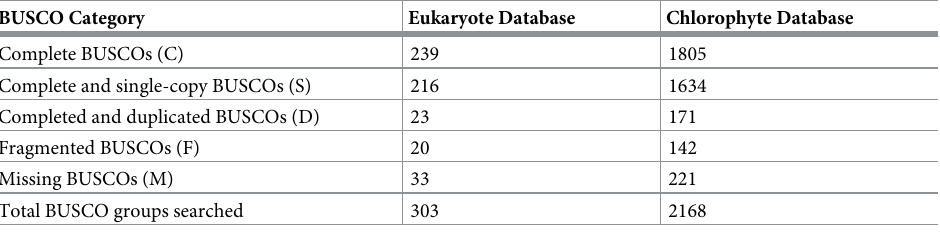
Table 2. BUSCO results breakdown of the completed A . falcatus assembly against the eukaryote and chlorophyte databases. The eukaryote BUSCO results can be summarized as C:82.5%[S:78.9%,D:3.6%], F:6.6%, M:10.9%, n:303. The chlorophyte BUSCO results can be summarized as C:83.3%[S:75.4%,D:7.9%], F:6.5%, M:10.2%, n:2168.